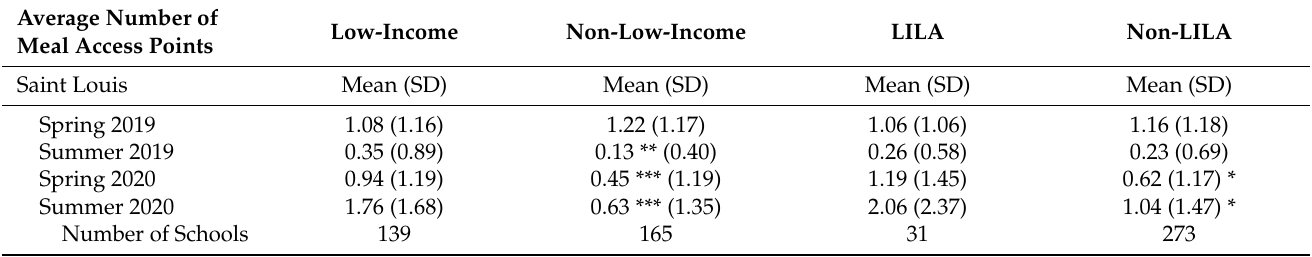
Table 2. Food need and access in St. Louis by census